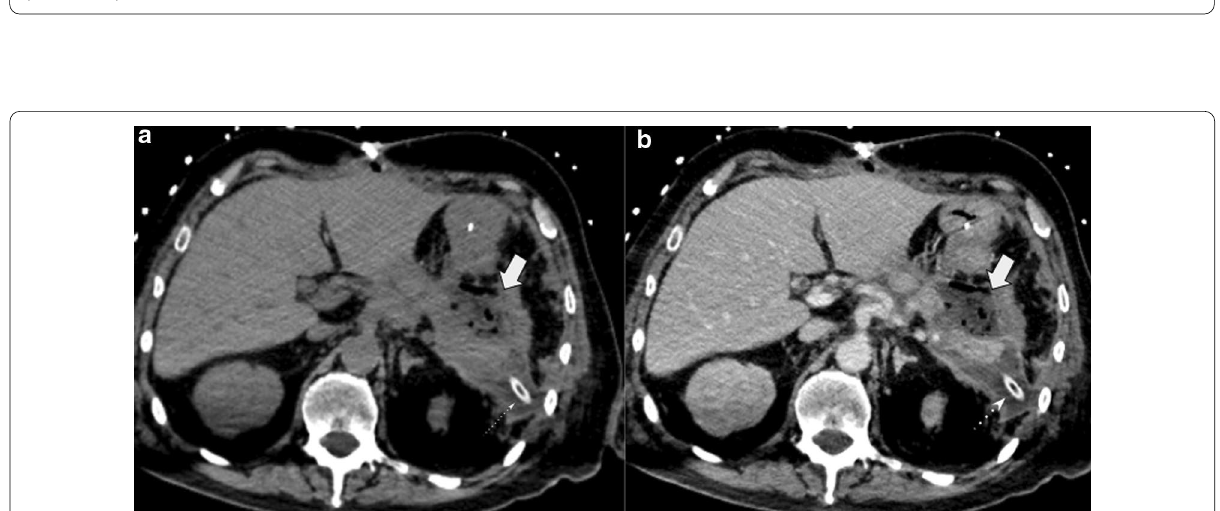
Fig. 16 Abdominal abscess ( a ) Axial non-contrast CT scan. ( b ) Axial portal venous phase CT scan. 52-year-old female patient with fever after 20 days of pancreaticoduodenectomy due to mucinous cystic tumor. CT scan showed heterogeneous fluid collection with air content (big arrow). Drainage (dotted arrow) analysis disclosed purulent